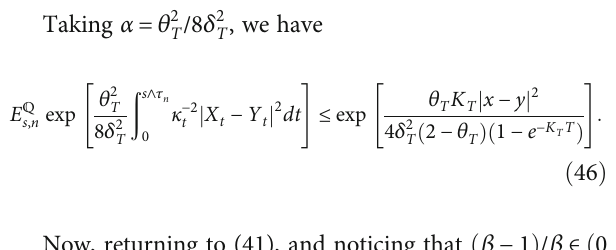
ffiffiffiffiffiffiffiffiffiffiffiffiffiffiffiffiffiffiffiffi r T 1 + r r T